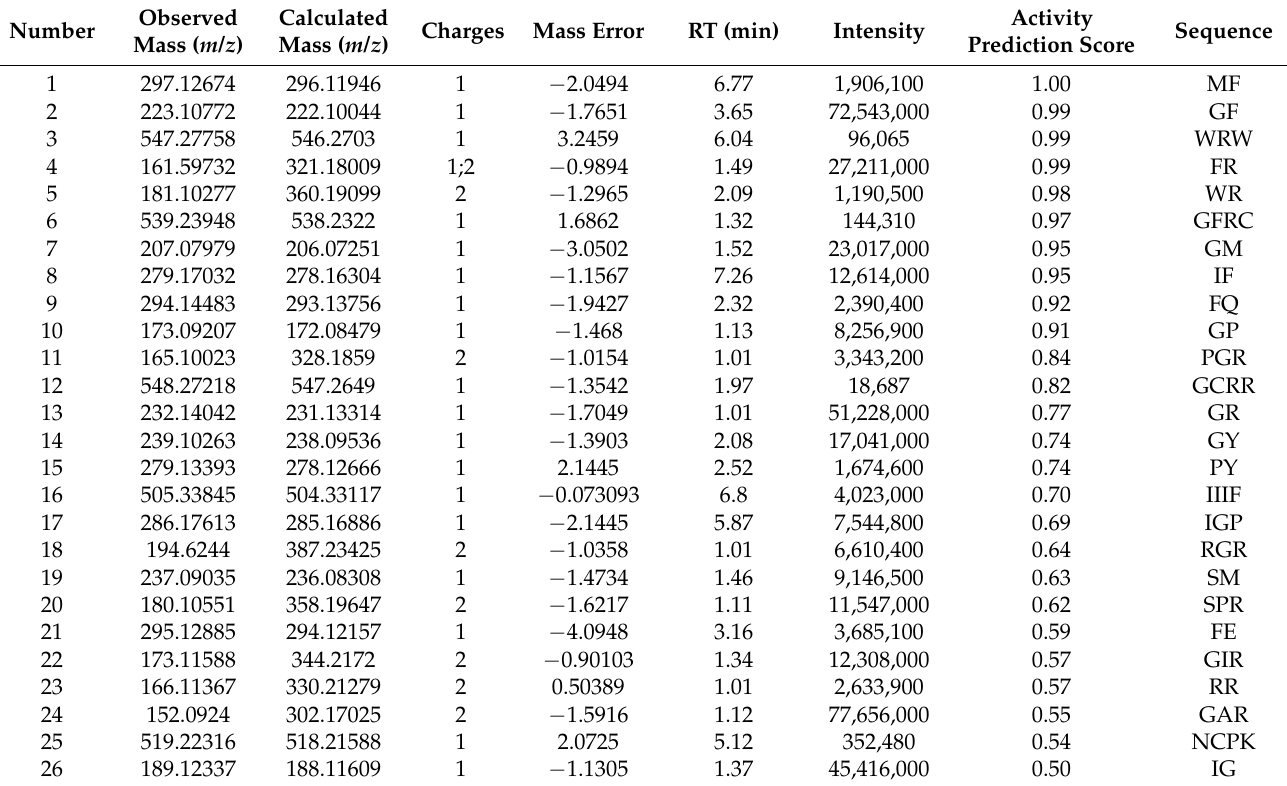
Table 2. Determination of the SCH oligopeptide sequence by